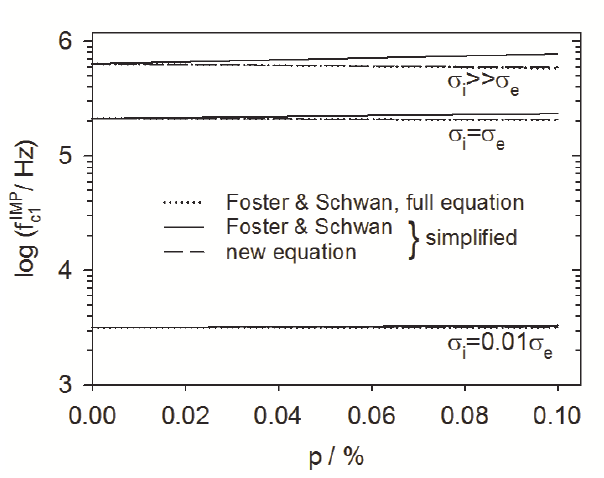
IMP obtained from Fig. 11: Volume fraction dependencies of f c 1 >>σ =σ = 0.01 σ , σ , and σ . four different models for σ i e i e i e Equation (18) corresponds to the complete model of Foster and IMP Schwan [1996] (dotted lines). While their simplified f c 1 expression slightly increases with p (full lines), the new equation (20) predicts a moderate decrease (dashed lines), in accordance with the complete models. In all models, the points for p=0 are IMP = f (equations identical with f c 1 c 1